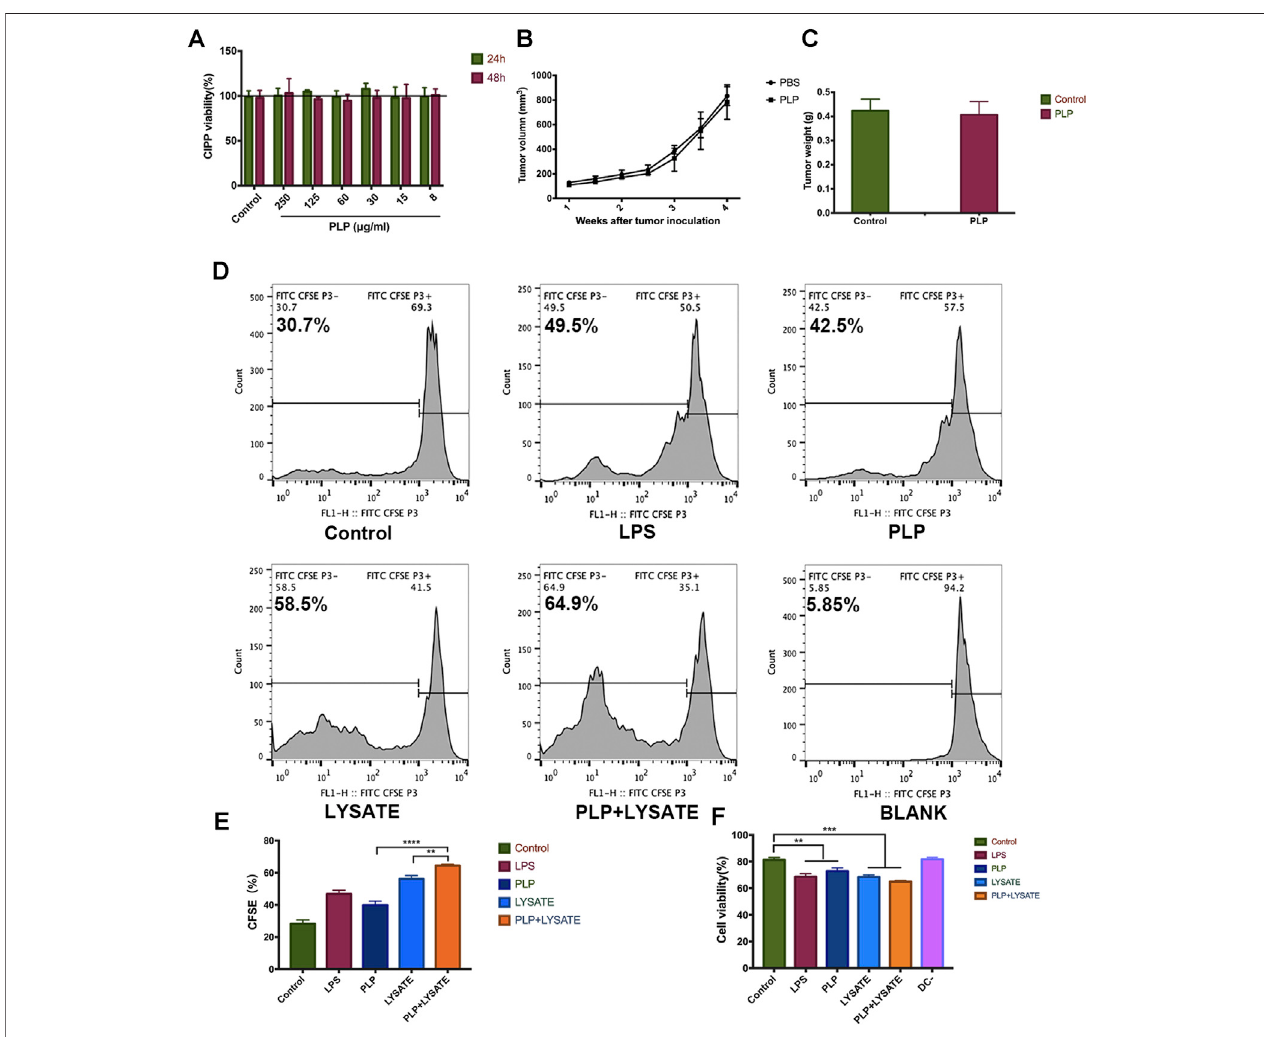
FIGURE4| PLPenhancedtumorantigen-speci fi cimmuneresponsesagainsttumorlysate-pulsedDCs. (A) CytotoxiceffectsofCIPpcellswereanalyzedusingCell Counting Kit-8 at 8, 15, 30, 60, 125, and 250 μ g/ml PLP treatment. (B) Mean tumor growth curves given by tumor volume in BALB/c nude mice. Mice were